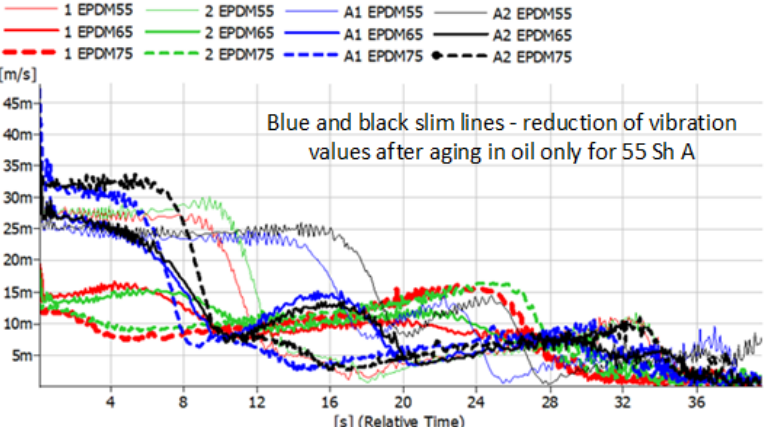
Figure 13. Vibration parameters during the run-down process with EPDM rubber absorbers installed in the vibration insulation system.